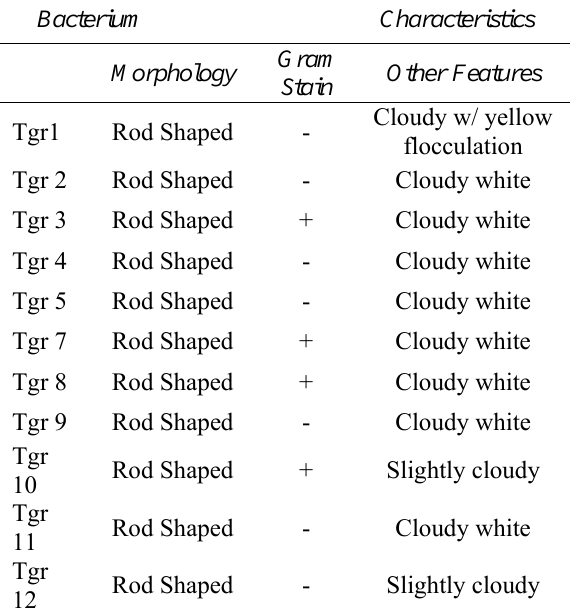
Table 1 : Characteristics of soil bacterial isolates: Isolates were grown in MM for 24 hours and Gram stained according to the Becton-Dickinson Gram Stain Protocol Growth and Viability of Tgr3